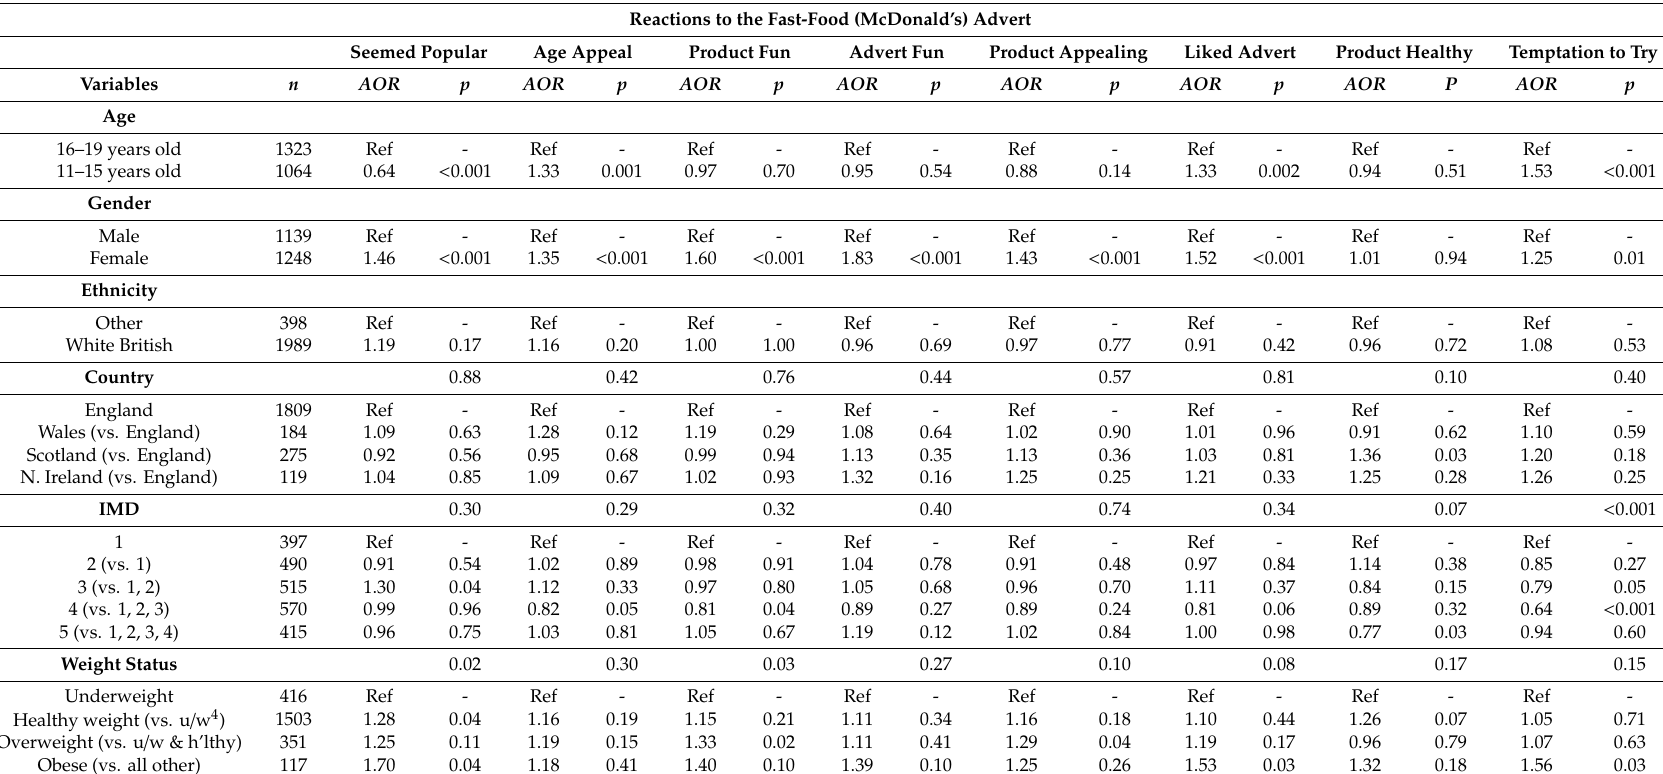
Table 3. Reactions to the fast-food advert and associations with demography and the BMI